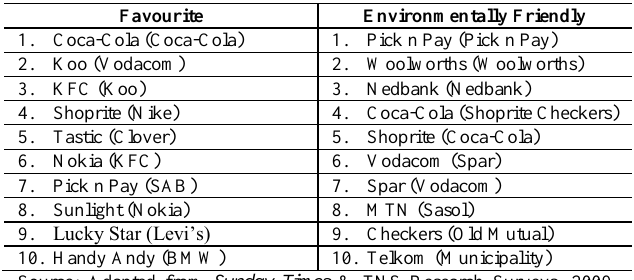
Table 1: South Africa’s top brands – Favourite